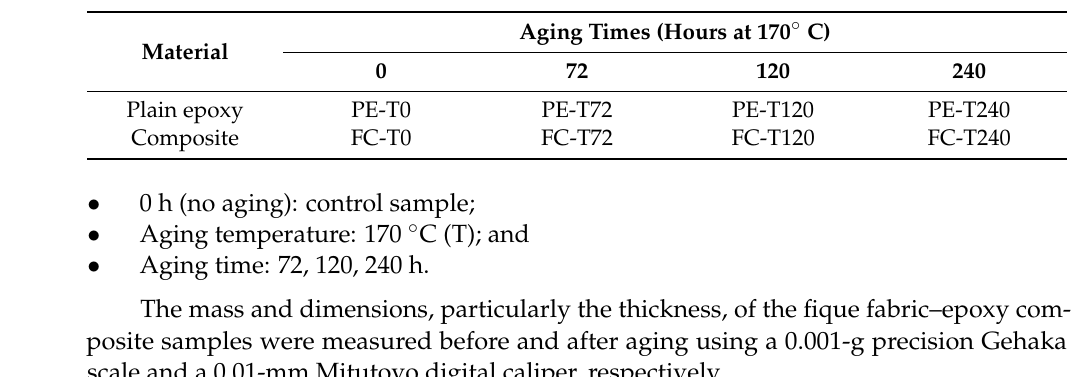
Table 1. Nomenclature adopted for DMA